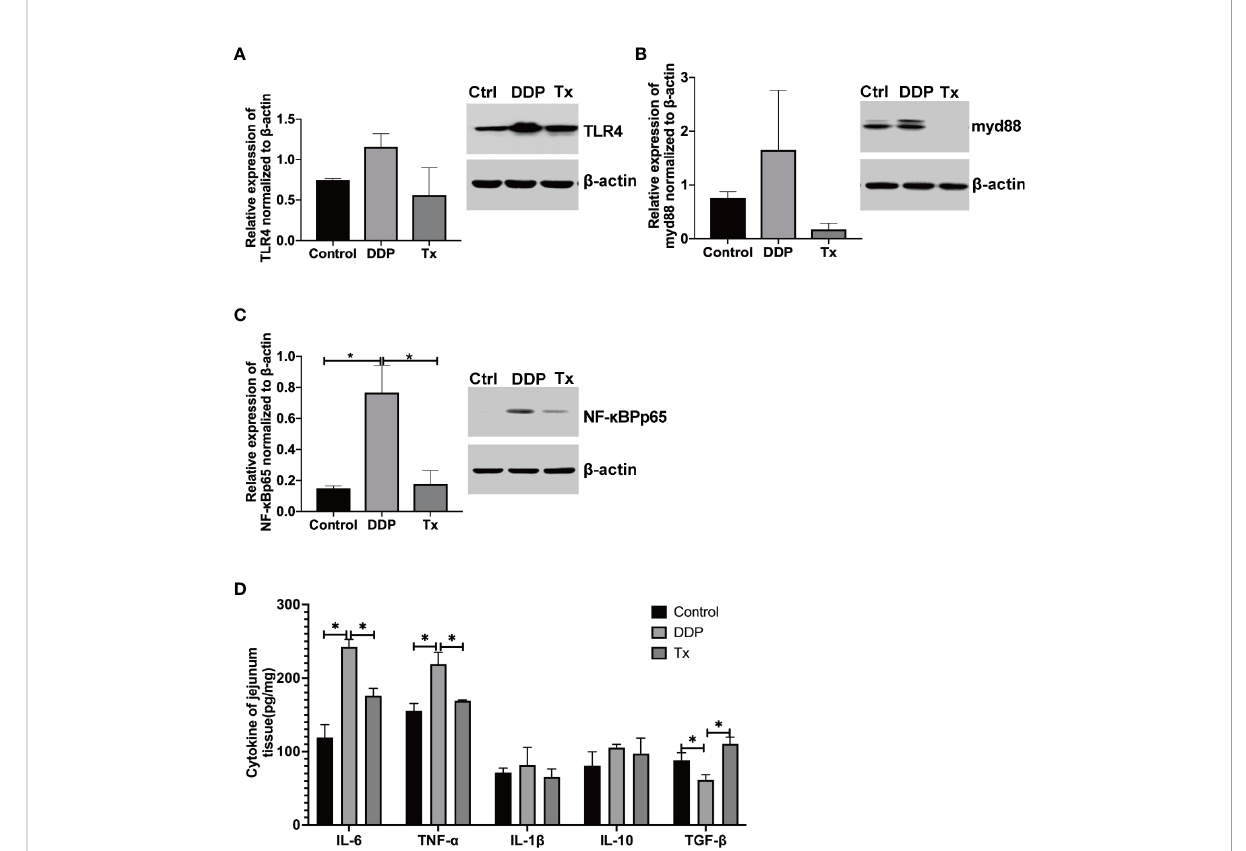
FIGURE 5 LJAW Downregulated Proin fl ammatory Cytokine Expression in Jejunum Tissues. (A – C) western blotting of the expression of the proin fl ammatory cytokine-related proteins TLR4, myd88, and NF- k B p56 in jejunum tissues of LJAW-treated rats, cisplatin-treated rats and vehicle control-treated rats(n = 3 in each group, A(a), B(a), C(a),western blots showing total levels of TLR4, myd88, and NF- k B p56 in Control-, DDP-, and LJAW-treated rats jejunum; A(b), B(b), C(b), Bar graphs showing mean TLR4, myd88, and NF- k B p56 levels determined by densitometry(n = 3, data are presented as mean ± sem, normality was tested by Shapiro-Wilk normality test, p values were determined by using one-way ANOVA, * p < 0.05). (D) Cytokine expressions of IL-6, TNF- a , IL-1 b , IL-10, and TGF- b in LJAW-treated rats, cisplatin or vehicle control- treated rats jejunum tissues. (n = 6, Data are presented as the mean ± sem. normality was tested by Shapiro-Wilk normality test, p values were determined by using one-way ANOVA * p <